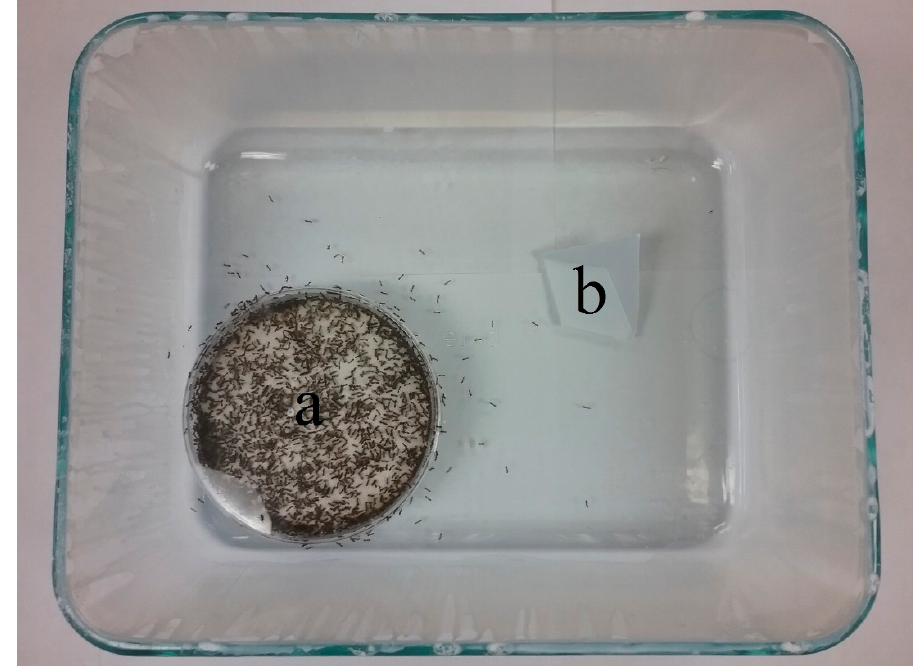
Figure 2. Test arena for item removal and mortality experiments. Nest chamber ( a ) containing ≈ 300 worker ants was provided, and 30 items (ants or paper wicks) were placed onto the floor of the arena on a plastic platform ( b ).